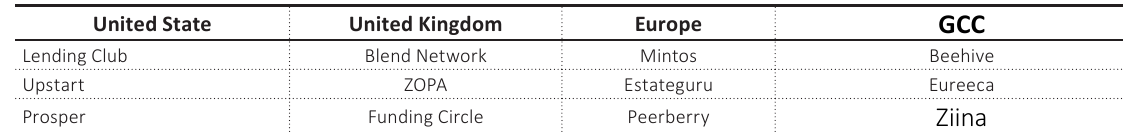
Table 2. Peer-to-peer lenders in different